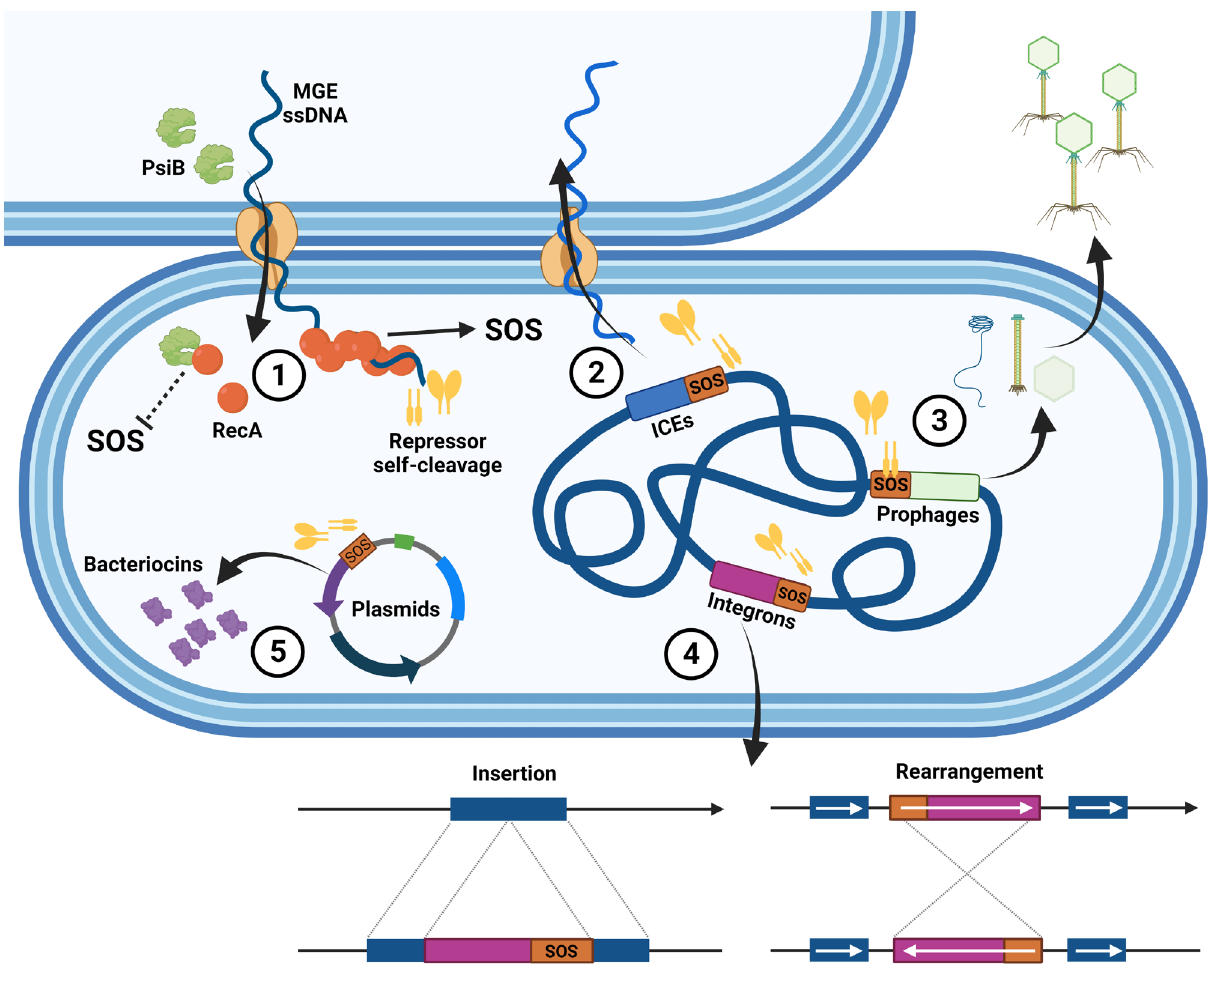
Figure 2 – Schematic representation of the involvement of SOS response with mobile genetic elements (MGE). (1) Entry of mobile elements ssDNA in the host cell induces the SOS response by the formation of RecA* filaments, however some MGE encode proteins (such as PsiB) that are able to bind free RecA, avoiding all functions of RecA including the initiation of the SOS response. (2) The SOS response regulates the transfer of integrative and conjugative elements (ICEs) from the SXT/R391 family by interacting with SetR, repressor that self-cleaves after RecA* stimulus. (3) Bacteriophages may go from lysogeny to lytic cycle after induction of the SOS response, some phages show an SOS box sequence on promoter regions, others may encode represors, like the lambda bacteriophage CI repressor that self-cleaves after RecA* stimulus. (4) Chromosomal and mobile integrons show SOS box sequences in promoter regions, with transfer and rearrangement in the chromosome after the SOS response induction. (5) The SOS response regulates expression of bacteriocins, enforcing the maintenance of plasmids in the host